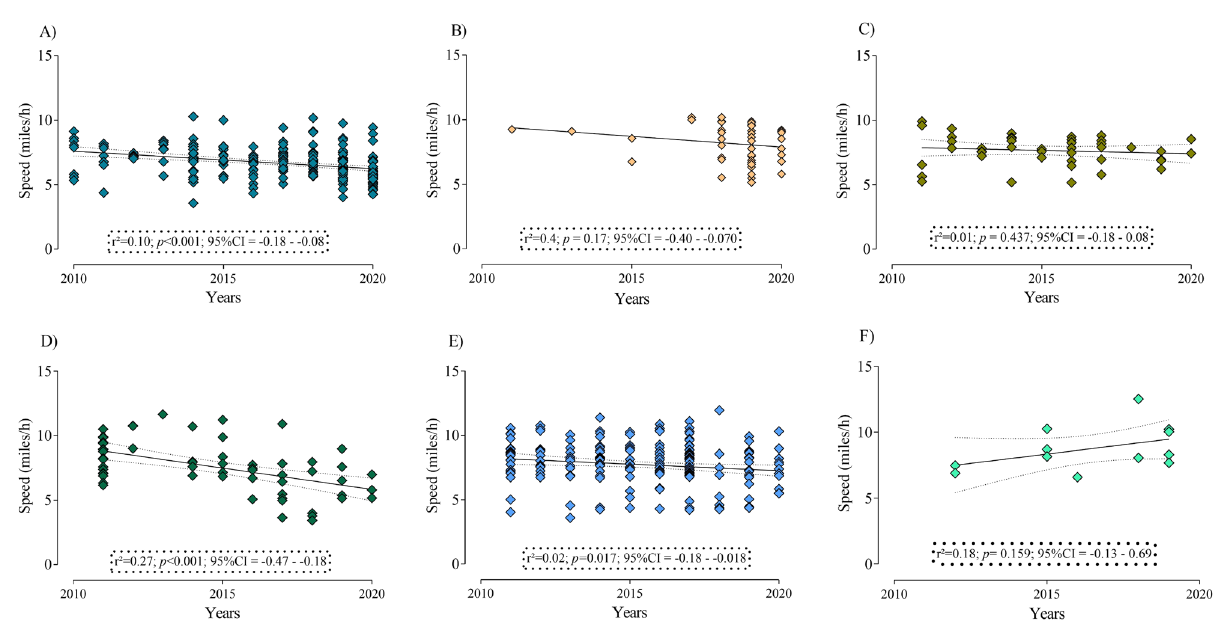
Figure 3. ( A ) Sweden women top three; ( B ) Hungary women top 10; ( C ) Russian women top 100; ( D ) Brazilian men top 3; ( E ) Russian men top 10; ( F ) Lithuanian men top